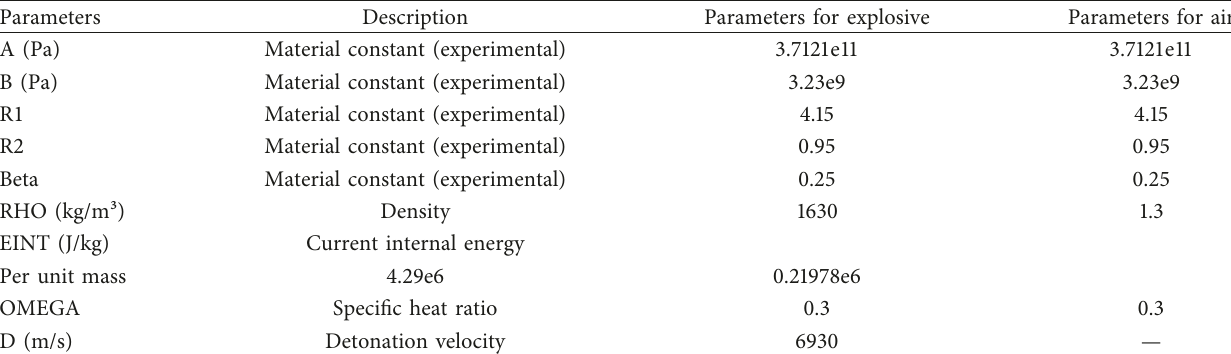
Table 1: Parameters for the JWL EOS for TNT (Dobratz and Crawford [31]).